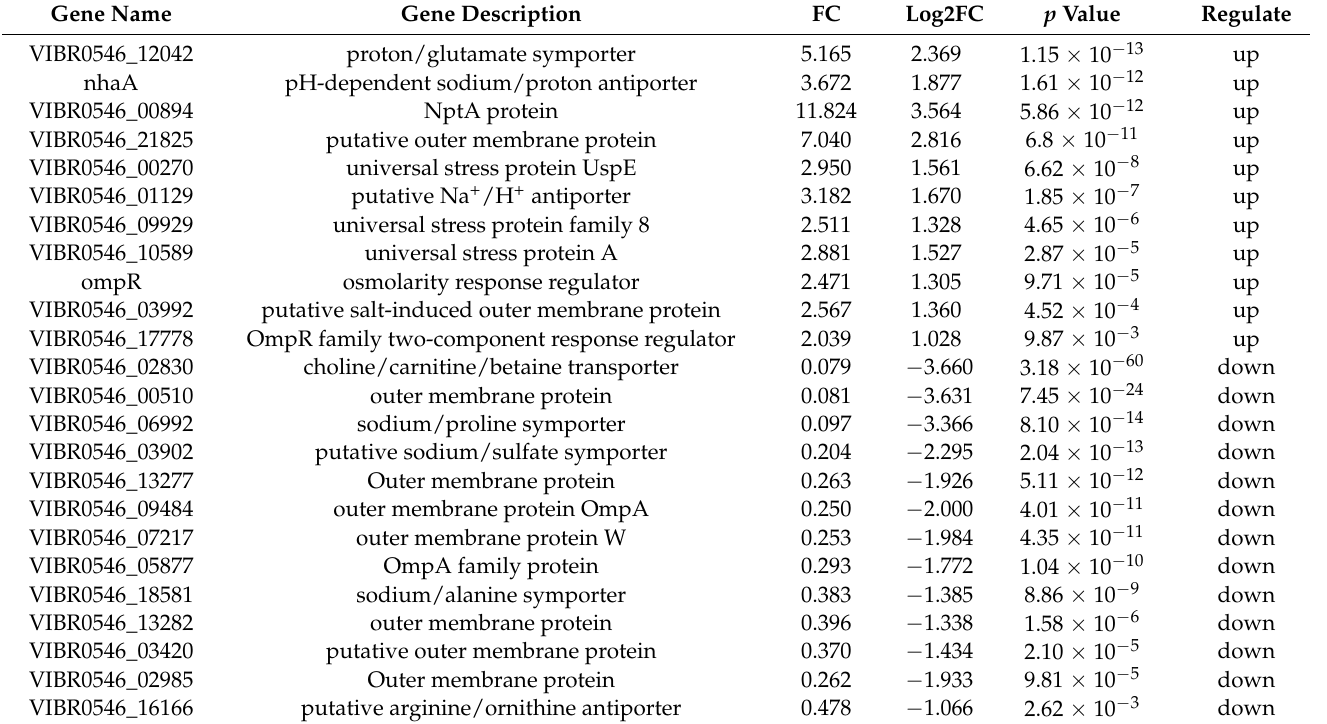
Table 2. The up and down-regulated genes of V. brasiliensis cultured in 0% NaCl medium. Gene